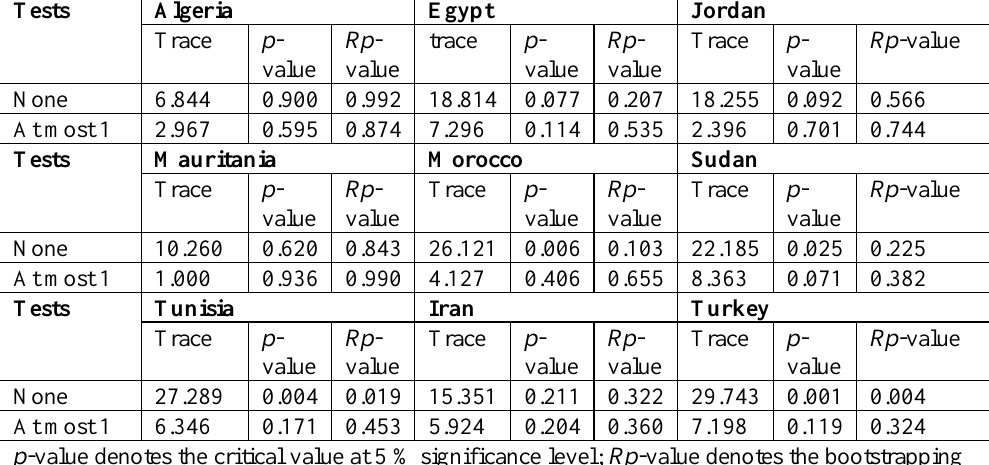
Table 7. Co-integration